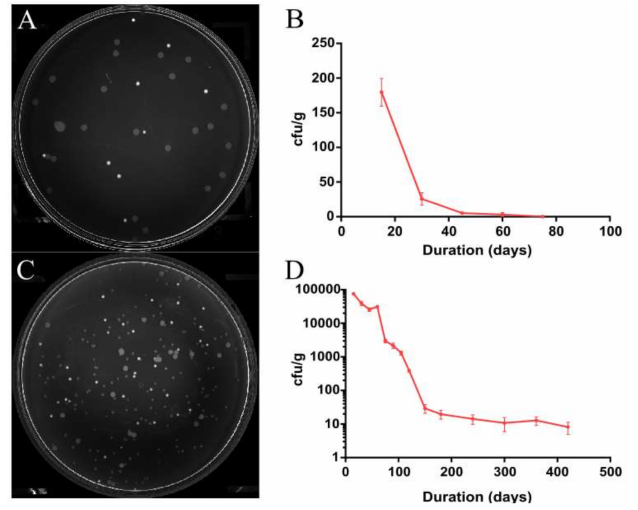
Figure 5. Stenotrophomonas maltophilia Smal-007 strain isolated from pine trees. ( A ) GFP tagged strain recovered from needles. ( B ) Colonization level of needles. ( C ) GFP tagged strain recovered from bark. ( D ) Colonization level of